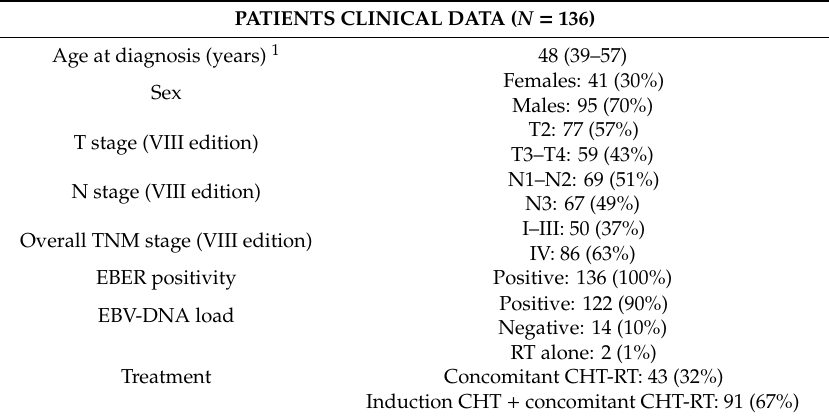
Table 1. Clinical and treatment characteristics for the patients with EBV-related nasopharyngeal cancers included in the study.